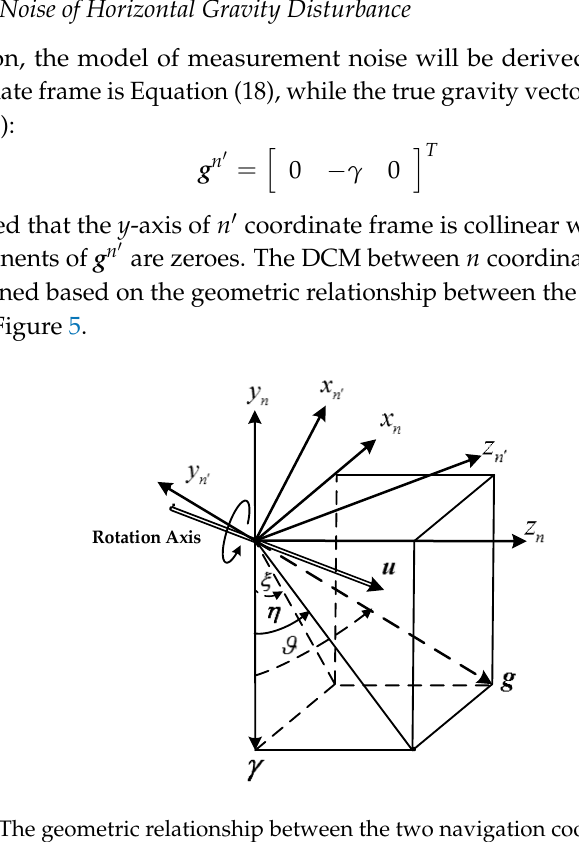
Figure 5. The geometric relationship between the two navigation coordinate frames.